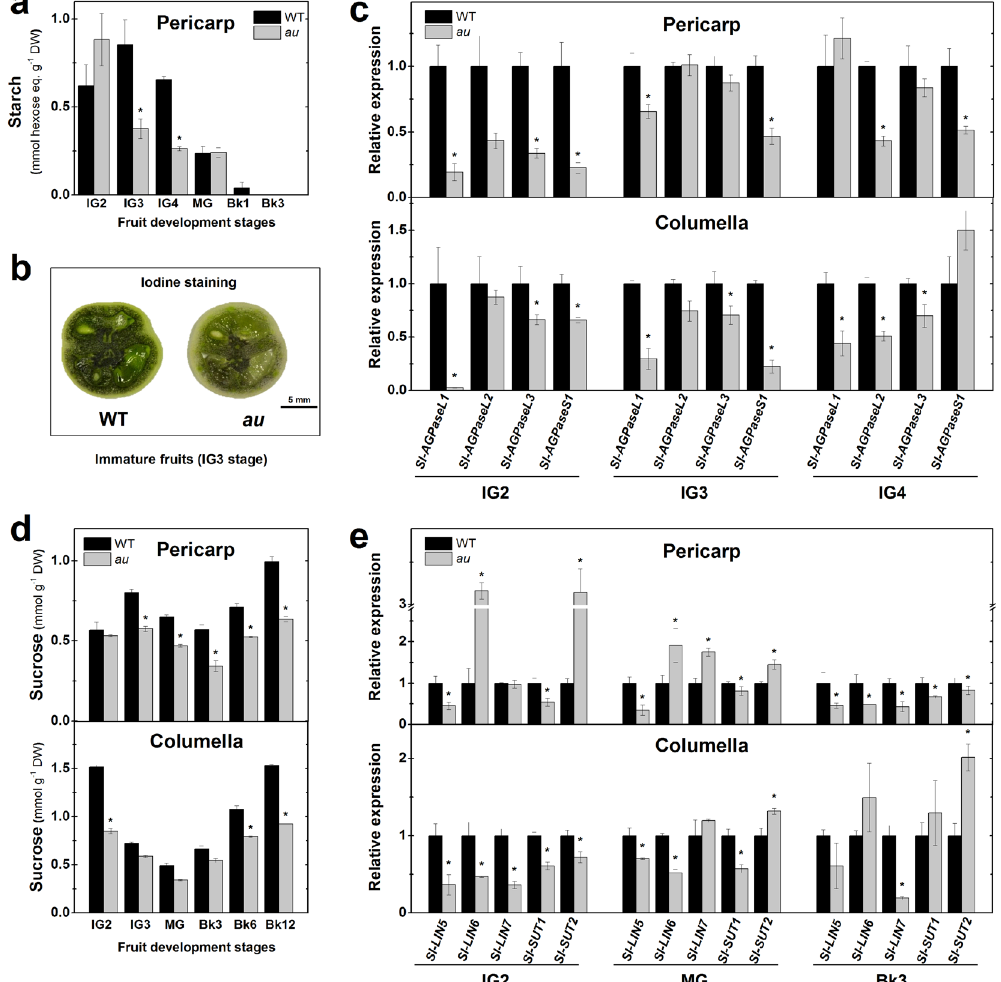
Figure 3. Deficiency in phytochromobilin negatively impacts fruit sugar accumulation and transcript abundance of sink- and starch biosynthesis-related genes. Carbohydrate content and transcript levels of sink-related genes were monitored in developing and ripening fruits of wild-type (WT) and aurea ( au ) mutant plants. ( a ) Starch content in pericarp cells. ( b ) Lugol staining in immature fruits (IG3). The blue- purple color indicates starch reaction with iodine. ( c ) Transcript abundance of tomato genes encoding ADP- glucose pyrophosphorylase ( AGPase ) in immature green (IG2 to IG4) fruits. ( d ) Sucrose content in pericarp and columella tissues. ( d ) Transcript abundance of tomato genes encoding invertases ( Sl-LIN ) and sucrose transporters ( Sl-SUT ). Values shown are mean ± SE. Transcript abundance was normalized against WT at each fruit developmental stage. Asterisks indicate statistically significant differences (Student’s t-test, P < 0.05) compared with the WT at each fruit development stage. IG2 to IG4, immature green stages (corresponding to early fruit development); MG, mature green; Bk to Bk12, 0 to 12 days after breaker stage (corresponding to the ripening